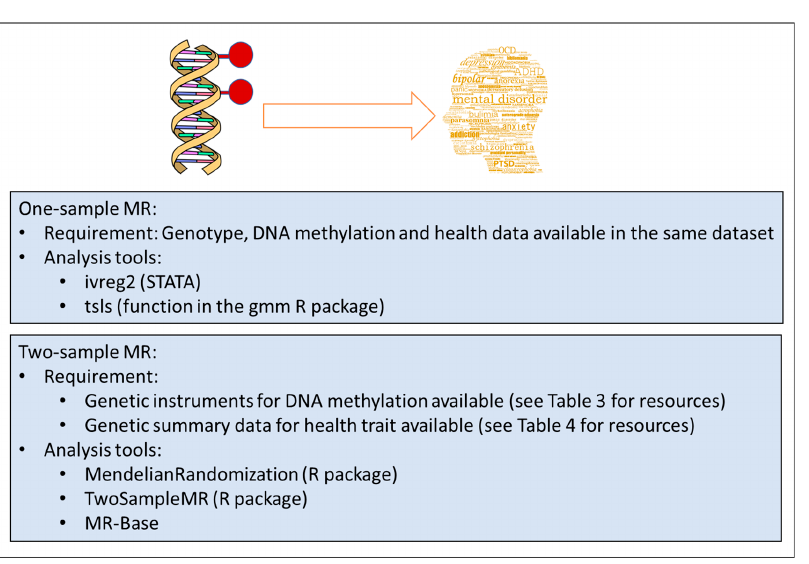
Figure 1. Overview of methodologies in epigenetic Mendelian Randomization (MR) analyses.